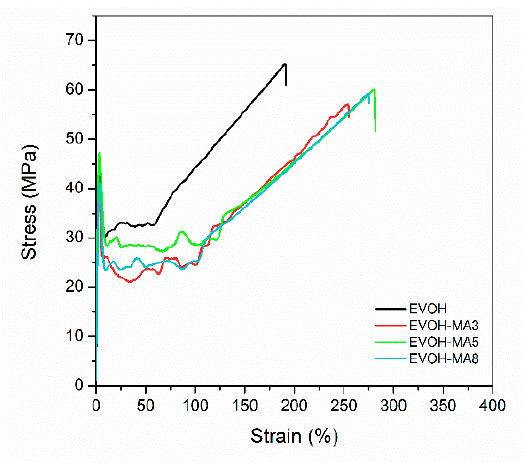
Figure 6. Representative stress-strain curves of EVOH-based films.